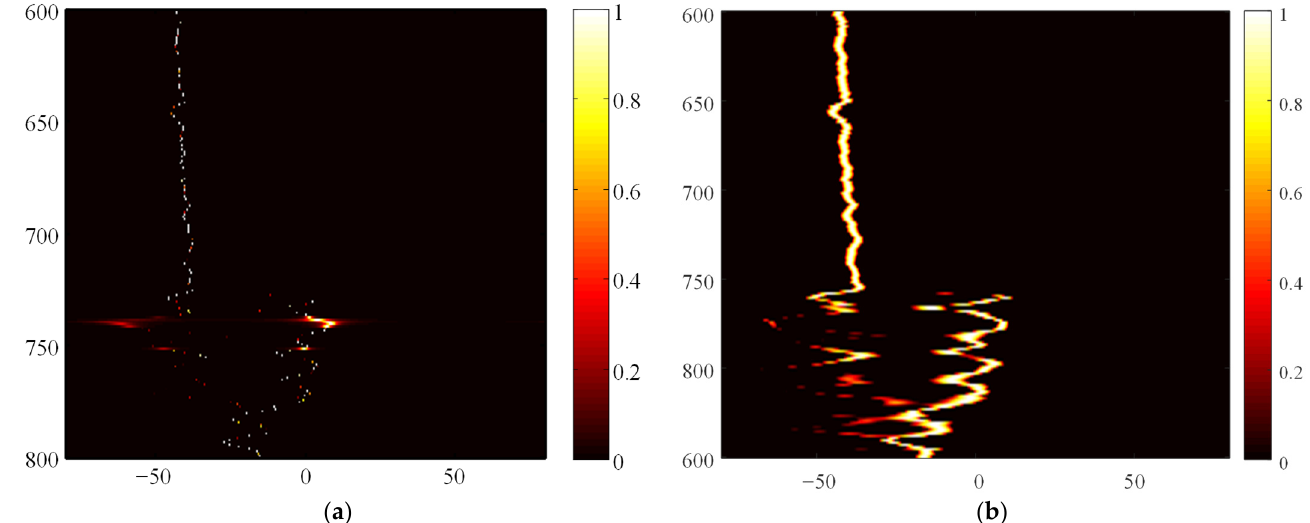
Figure 8. Normalized amplitude diagram. ( a ) Multi-look compressive sensing method ( b ) Separable approximate sparse reconstruction algorithm. The horizontal axes are heights in the elevation direction with the unit m, and the vertical axes represent pixels from 600 to 800 in the slant range.